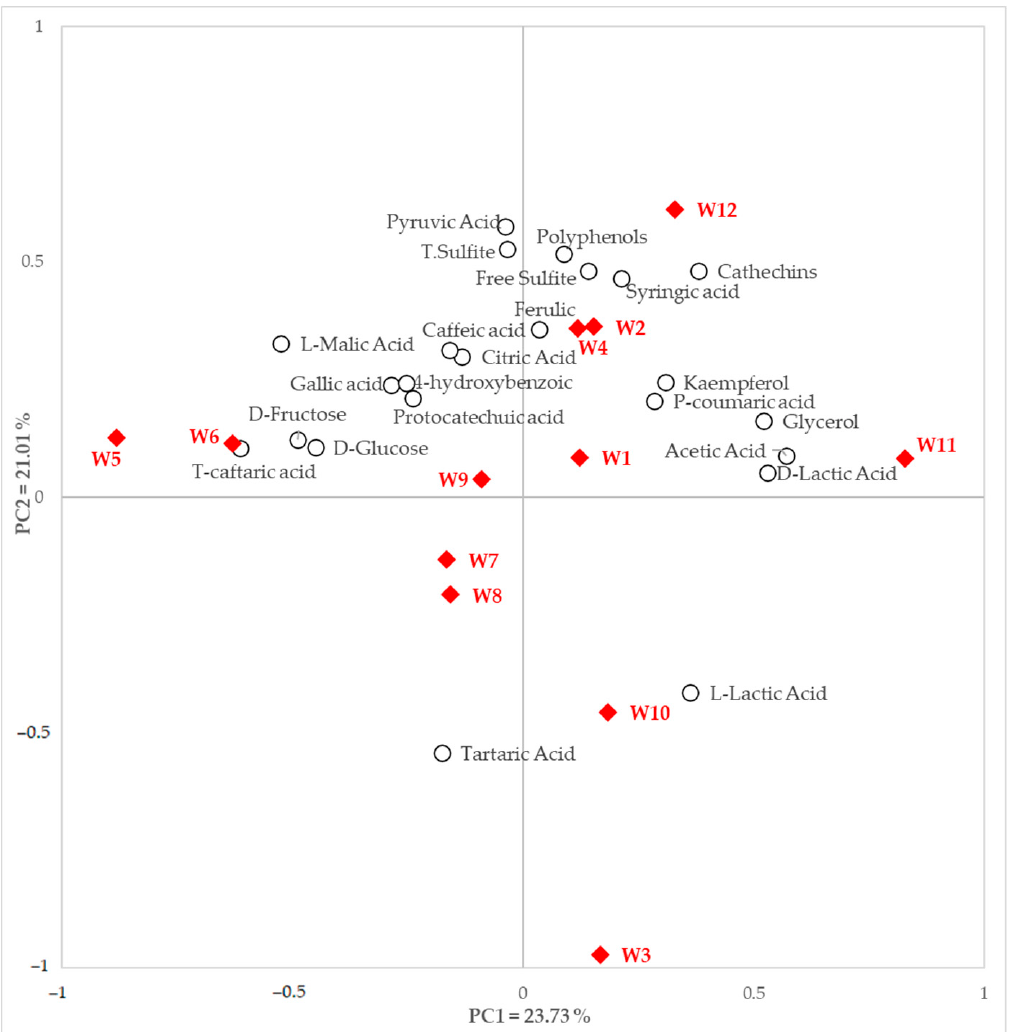
Figure 1. Principal component analysis (PCA) biplot of white wine samples and nonvolatile compounds data; filled diamonds indicate white wine samples and empty circles indicate nonvolatile compounds.